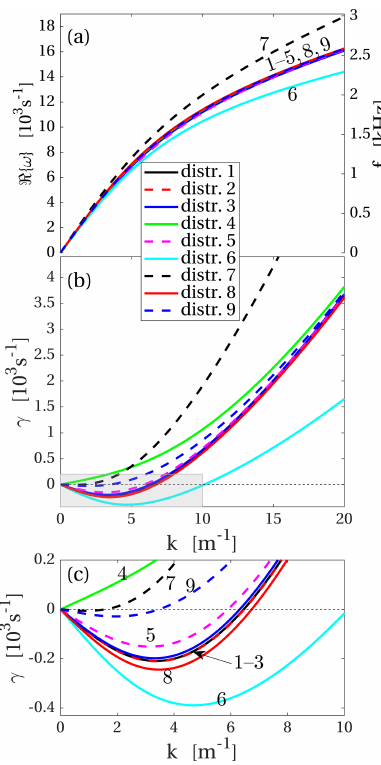
Figure 6. Dispersion relations at closest approach for the nine as- sumed distributions specified in Table 1. (a) Real part of the dis- persion relation. (b) Damping rate γ . (c) Close-up of the shaded rectangle in (b) . The numbers next to the curves identify the dif- ferent distribution functions shown in Table 1. Positive values of γ correspond to wave damping and negative values to wave growth.